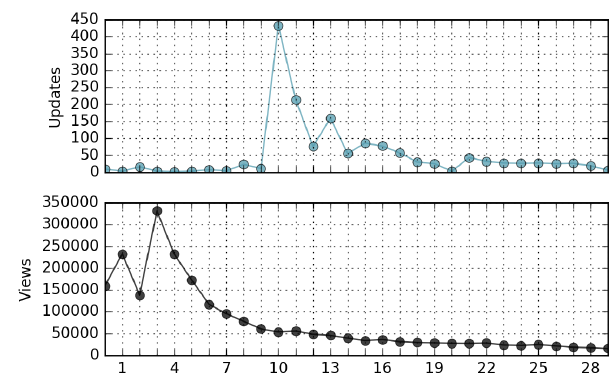
Figure 12. Views and updates of a popular music album page (“The Life of Pablo”) in February 2016, from 1 February to 1 March.